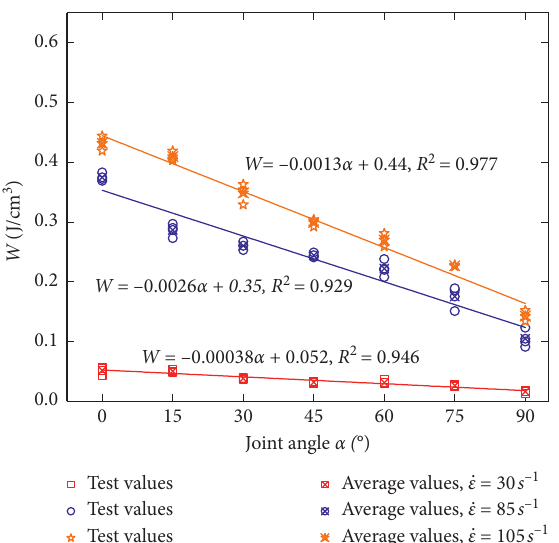
Figure 13: Variation in T W with joint angle under three different strain